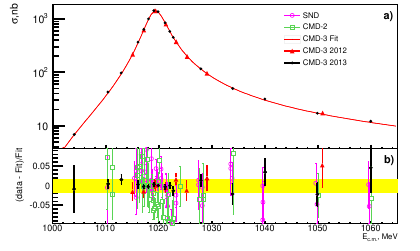
Figure 8. e + e − → K + K − cross section measured by CMD-3